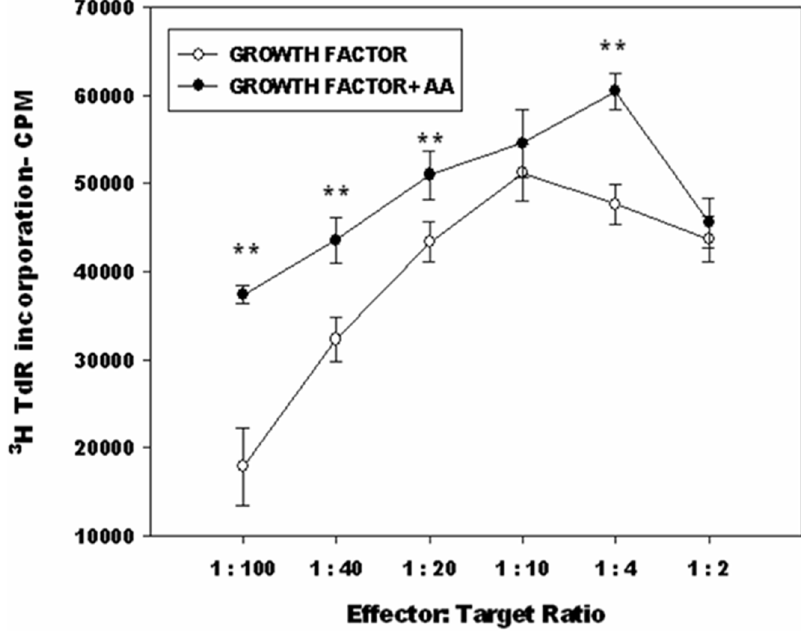
Figure 3. AA + DCs exhibit better MLR than AA - DCs: DCs generated were capable of efficient stimulation of allogeneic T cells. AA + DCs showed better T-cell stimulation than the AA - DC, differences were significant at four out of six DC:T-cell ratios tested (*P # 0.05,**P # 0.01). Representative data from three independent experiments is shown. TdR = thymidine.